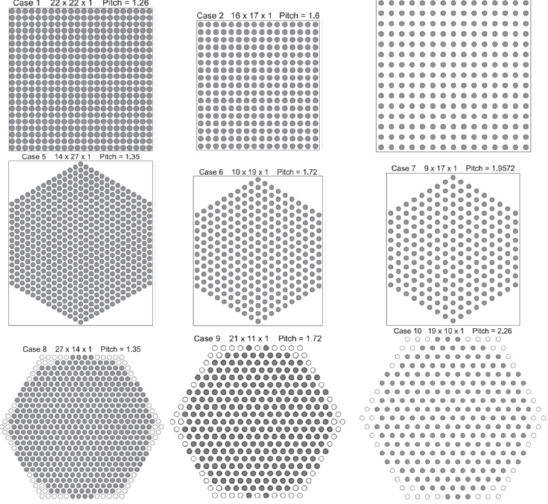
Fig. 6. E'/E-1 of keff of LCT-007 (added reactivities that cross section of H-1 and S( α , β ) of H 2 O were replaced to ENDF/B-VII.1 from